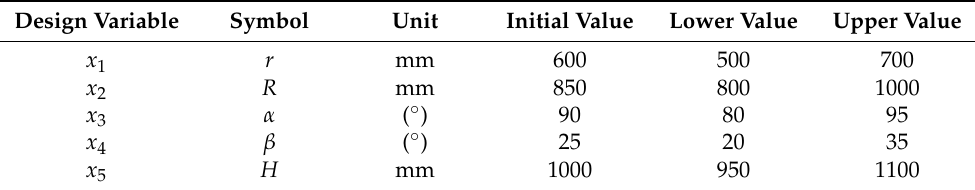
Table 2. Value range of design